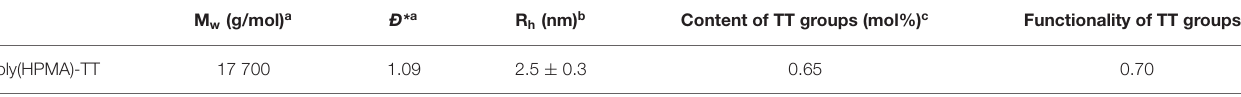
TABLE 1 | Physicochemical characterization of pHPMA precursor.